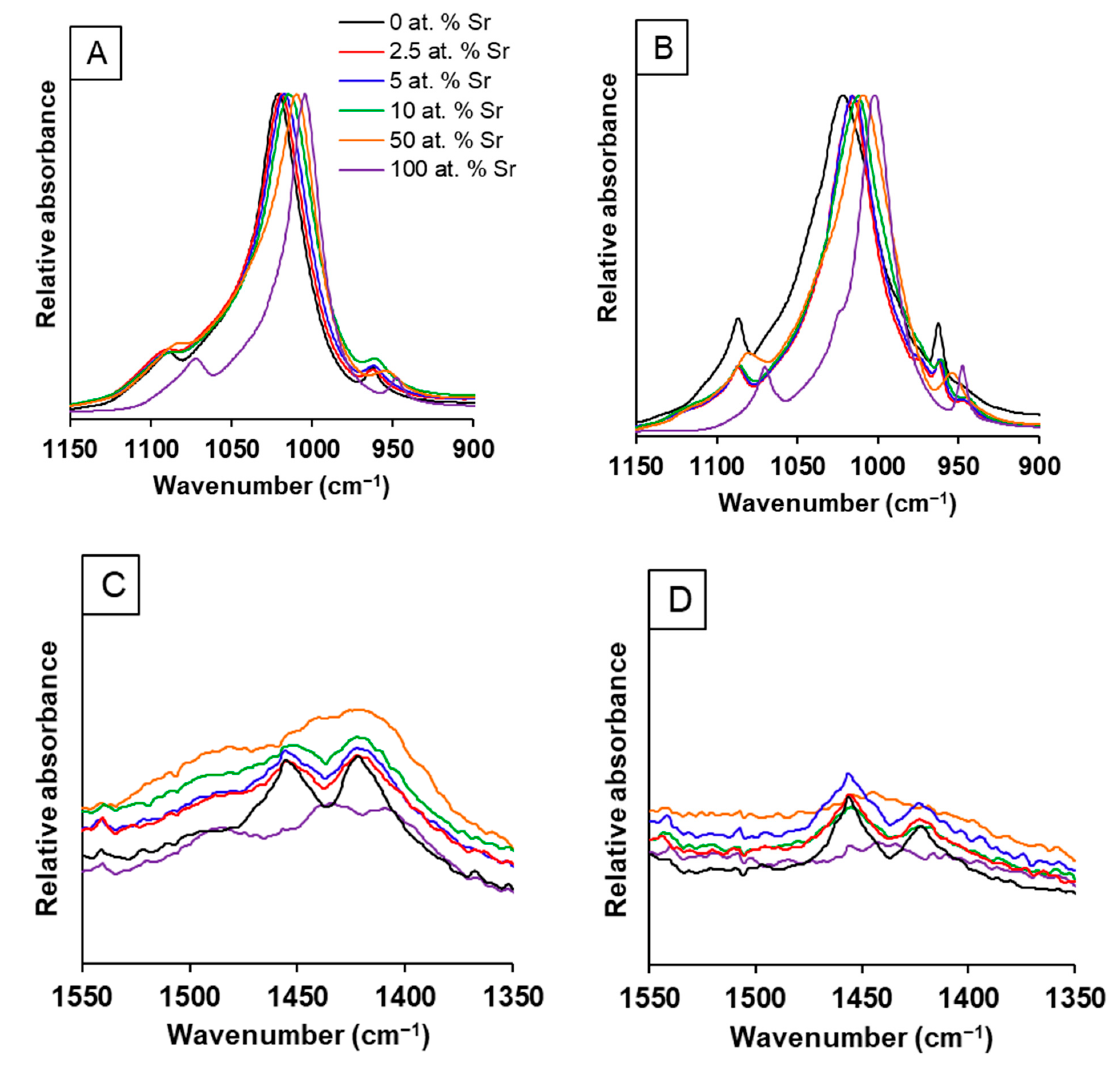
Figure 5. FTIR-ATR spectra of SrHA powders (0, 2.5, 5, 10, 50 and 100 at.% Sr) produced using the wet precipitation method. Phosphate peaks of unsintered ( A ) and sintered ( B ) powders. Carbonate peaks of unsintered powders from wet precipitation ( C ) and sol-gel ( D ) methods. Legend for all graphs as shown in A.